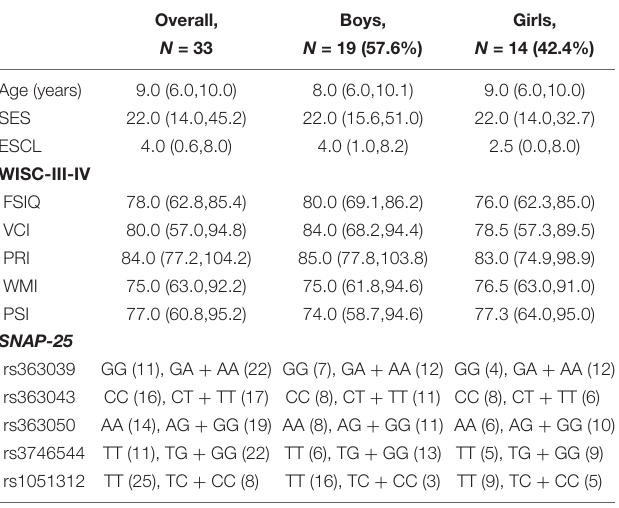
TABLE 1 | Median, 5th–95th centiles of age, socioeconomic status, environmental stress and psychometric scores. Overall, Boys,